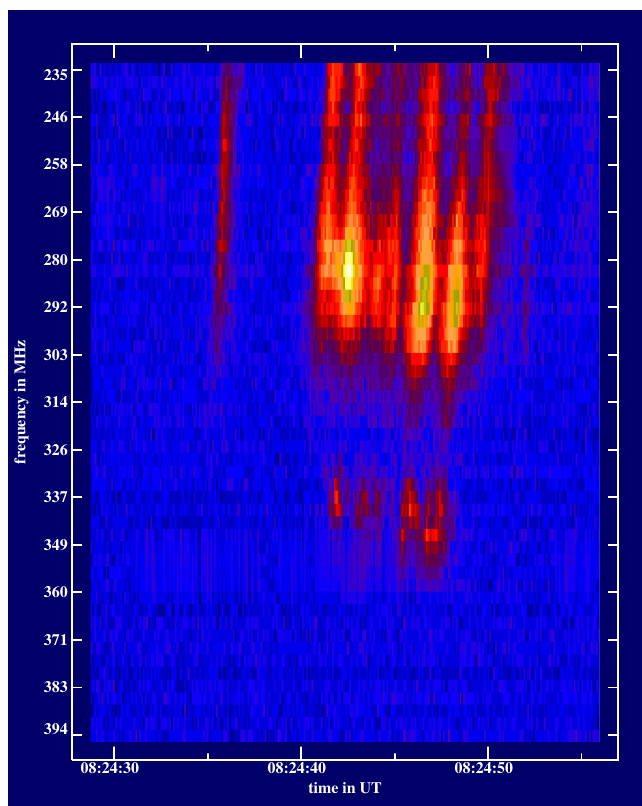
Fig. 20 Spectrogram of type III radio bursts (drifting structures in the upper right ) and meter wave type of narrowband spikes ( center ) that occurred on March 19,